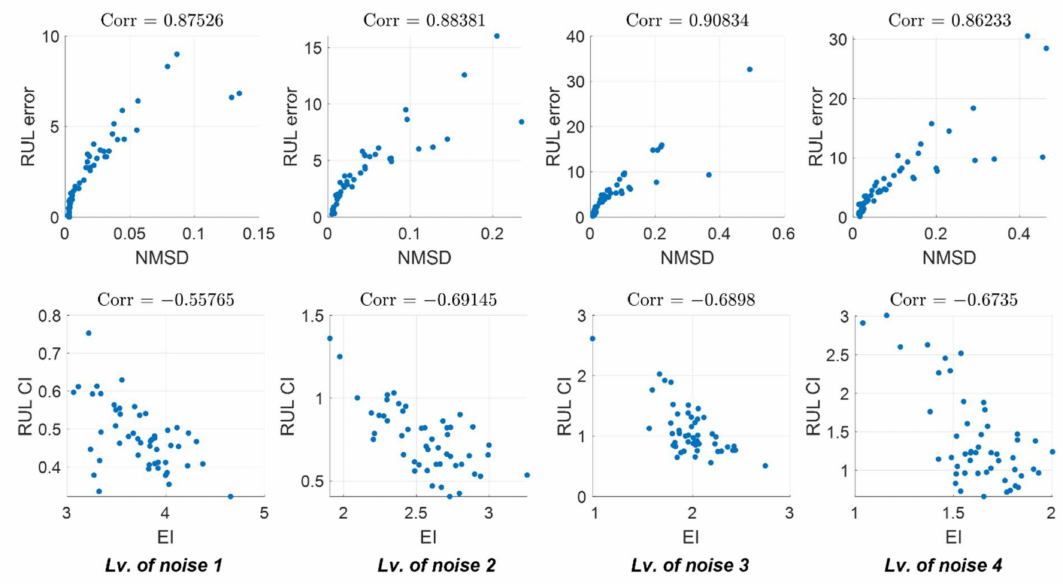
Figure 4. Correlation between two different metrics under varying noise.